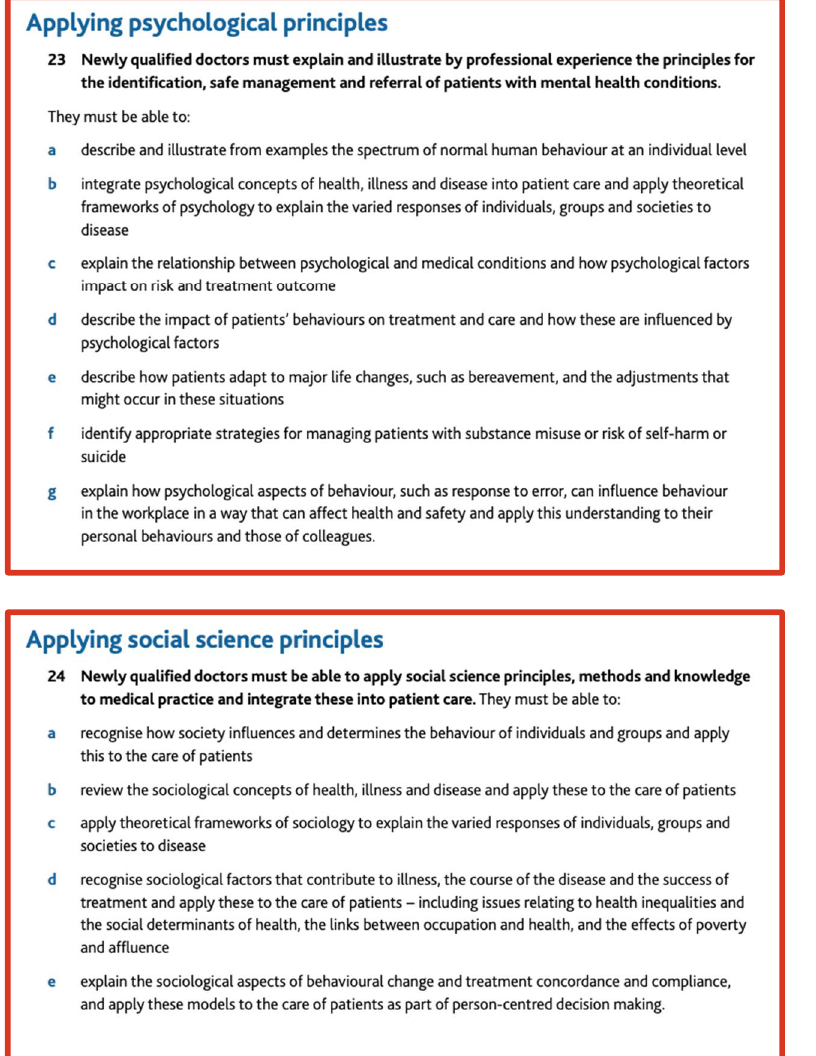
Figure 1. The behavioural and social science outcomes that medical students should meet upon graduation of a medical school in the United Kingdom